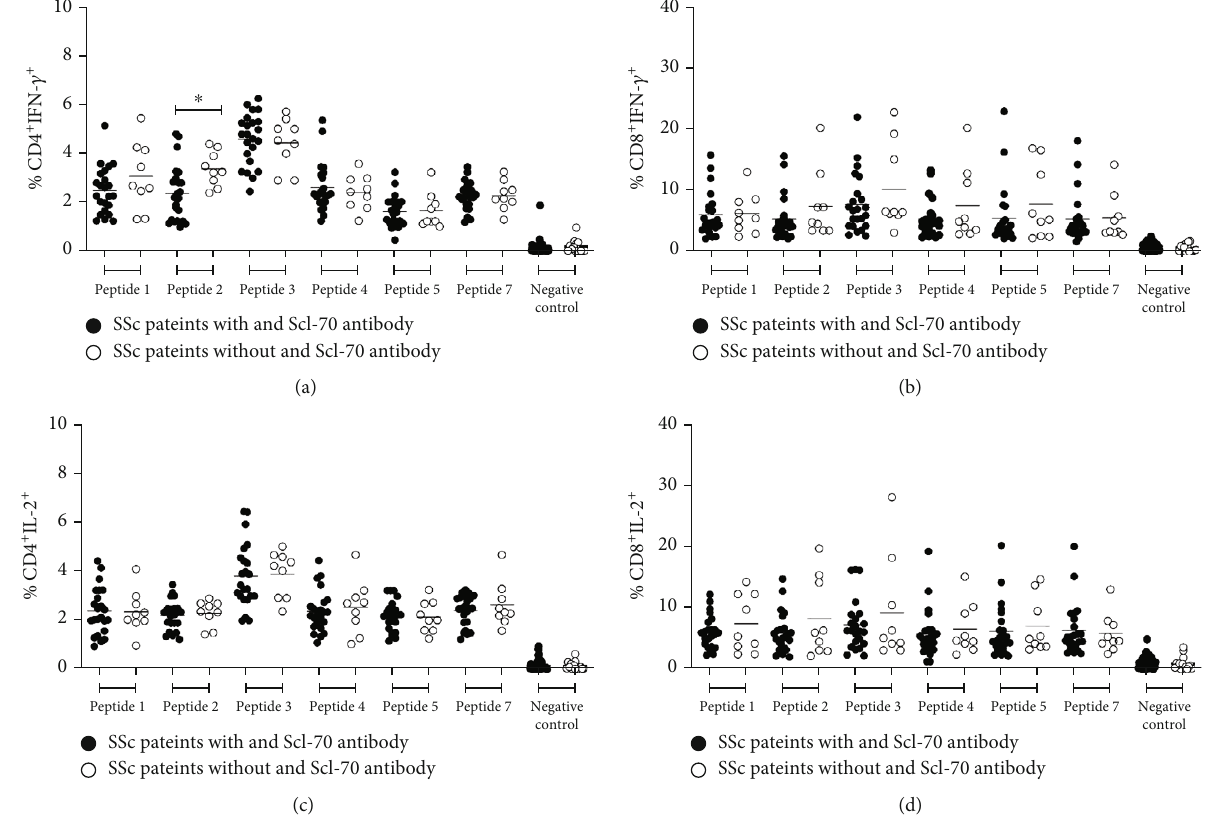
Figure 6: Percentage of cytokine (IFN- γ and IL-2) producing CD4 + (a, c) and CD8 + (b, d) T cells following stimulation with individual peptides in SSc patients ( n = 32 ), (Student ’ s t -test, ∗ p < 0 : 05